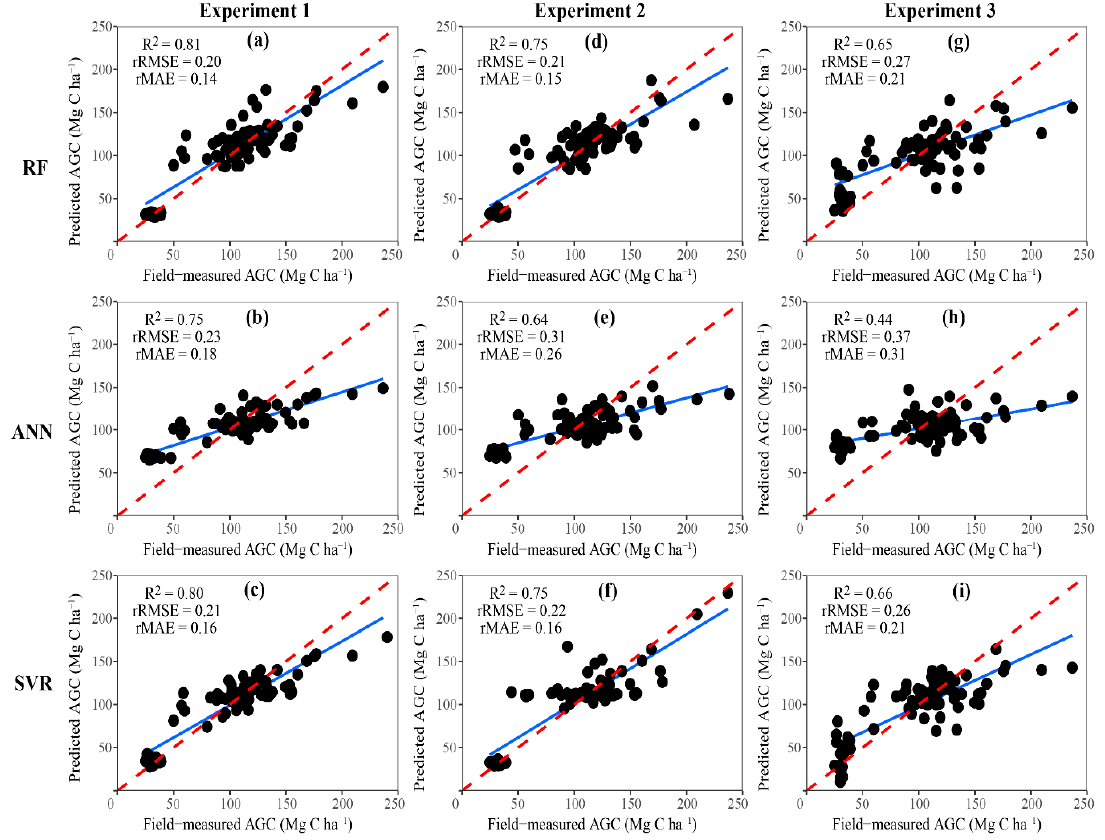
Figure 6. Field-measured aboveground carbon stock (AGC) values versus predicted AGC values from different models. Panels a, b, c, d, e, f, g, h, and i are in consistent with Table 4.